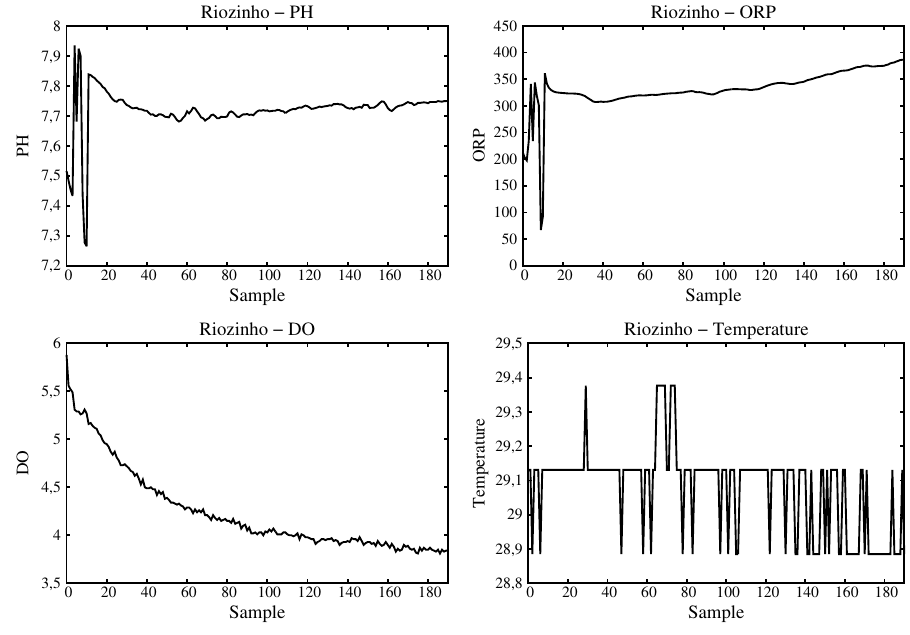
Figure 14. Data acquired and processed for Small River head (a very clean natural source).